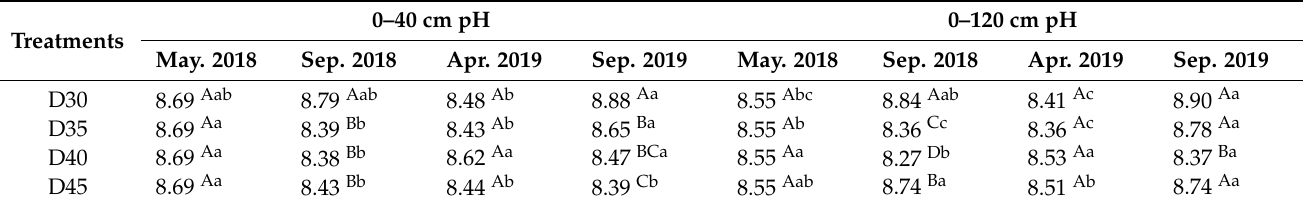
Table 4. The average pH in the 0–40 cm and 0–120 cm soil layers during the different sampling periods. Treatments